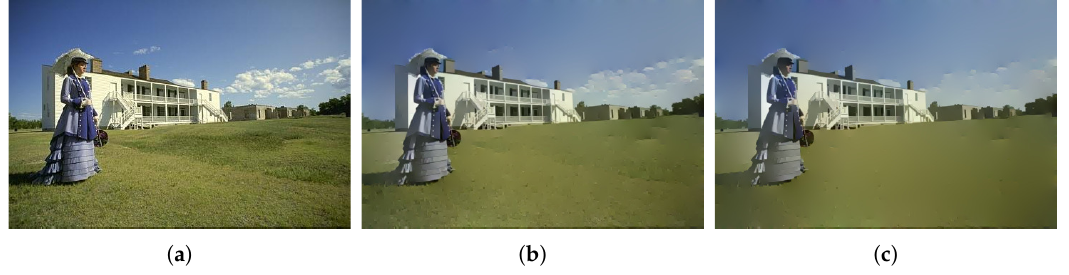
Figure 4. Output of solving (5) repeatedly with λ = 15, σ = 0.6. ( a ) Input image I ; ( b ) image after one iteration; ( c ) image after three